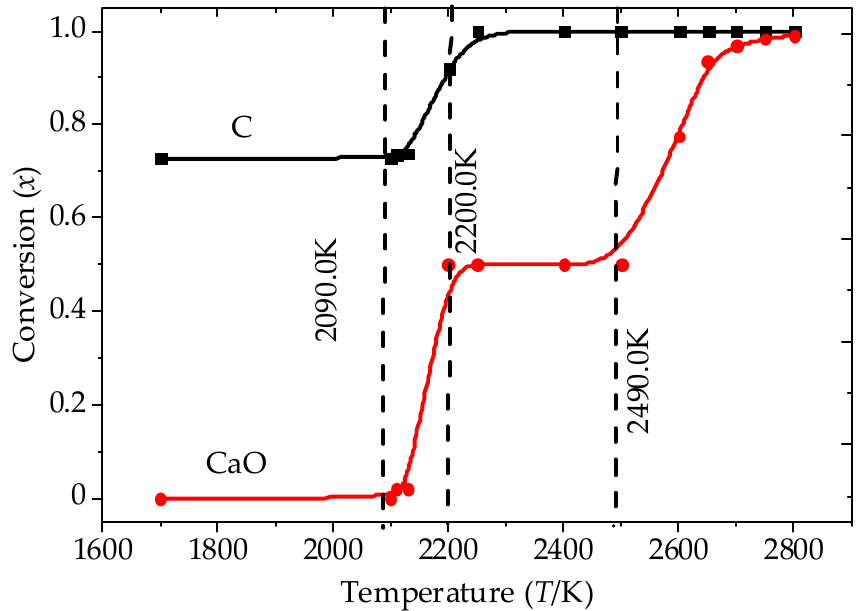
Figure 16. The conversion of C and CaO at each reaction temperature.